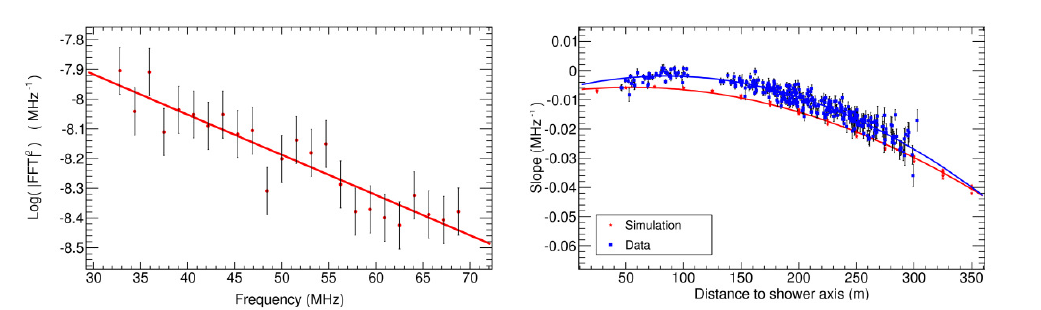
2 as function of frequency for one antenna of one selected event; the FFT | |